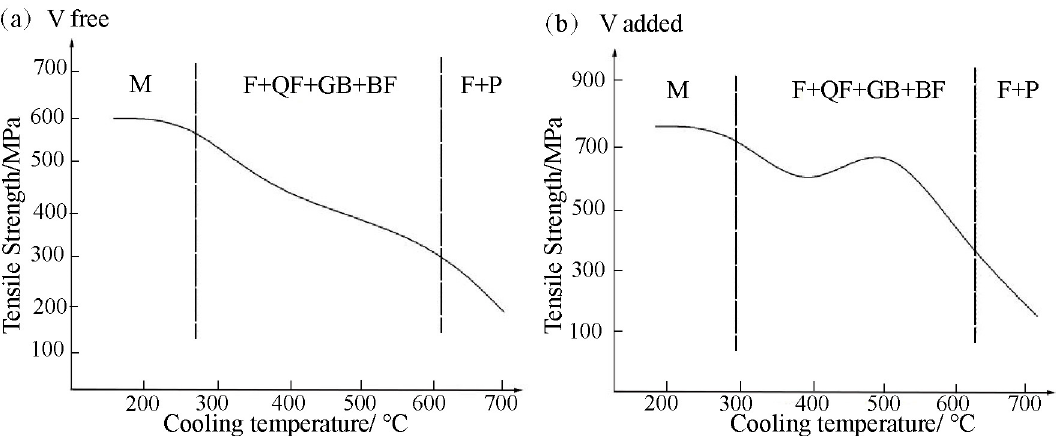
Figure 11. The relationship between tensile strength and coiling